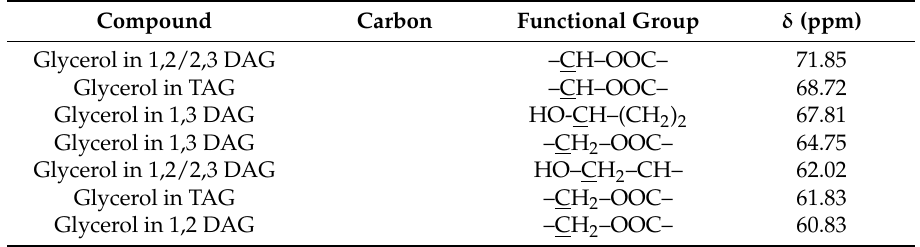
Table 16. 13 C-NMR peak assignments of the carbons of the glycerol moiety in CDCl 3